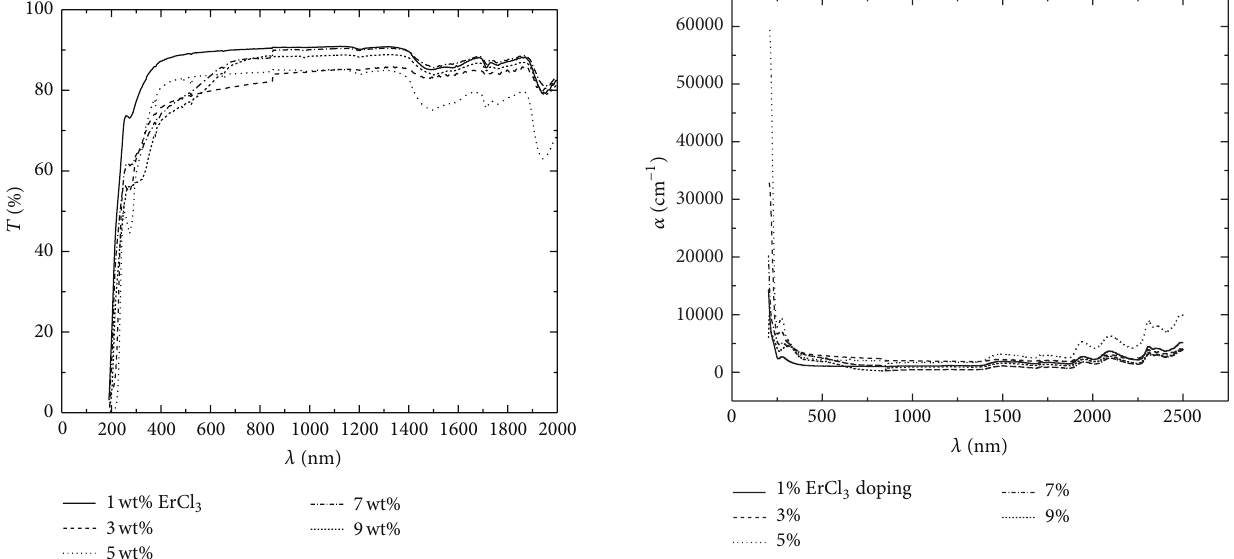
Figure 5: Absorbance of the wavelength for PVA contains different doping concentrations of ErCl 3 .